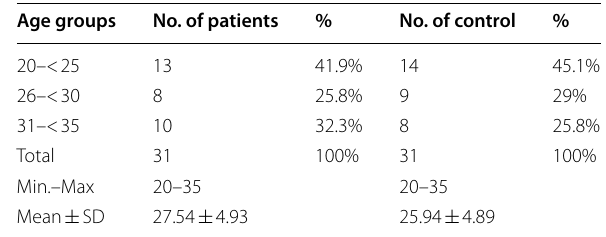
Table 2 Distribution of age of the studied patients and control